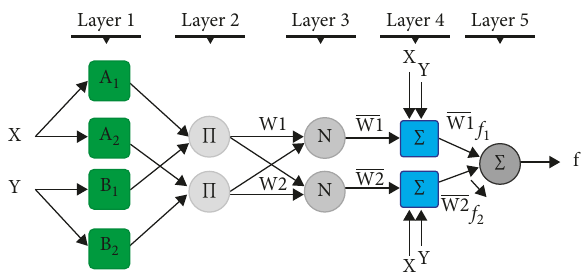
Figure 9: Structure of ANFIS model used in this